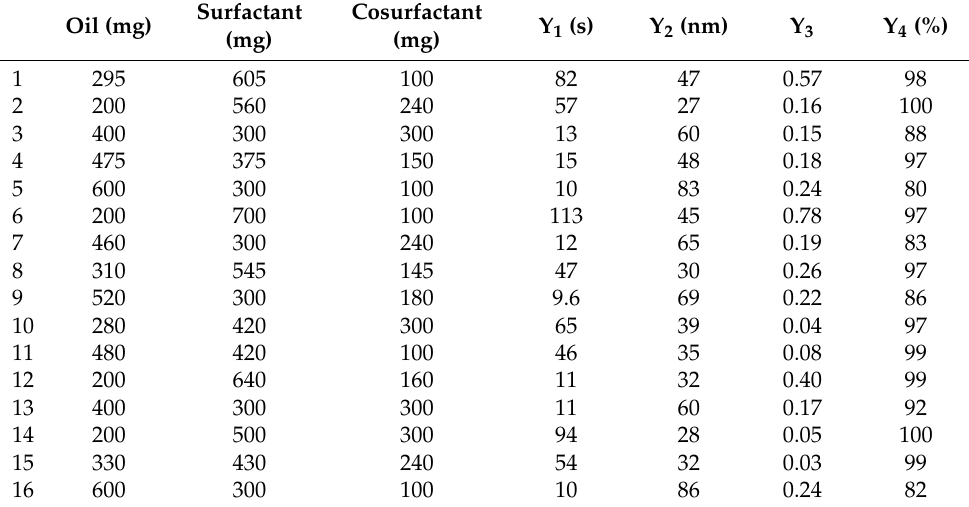
Table 2. D-optimal mixture design and response data for the optimization of